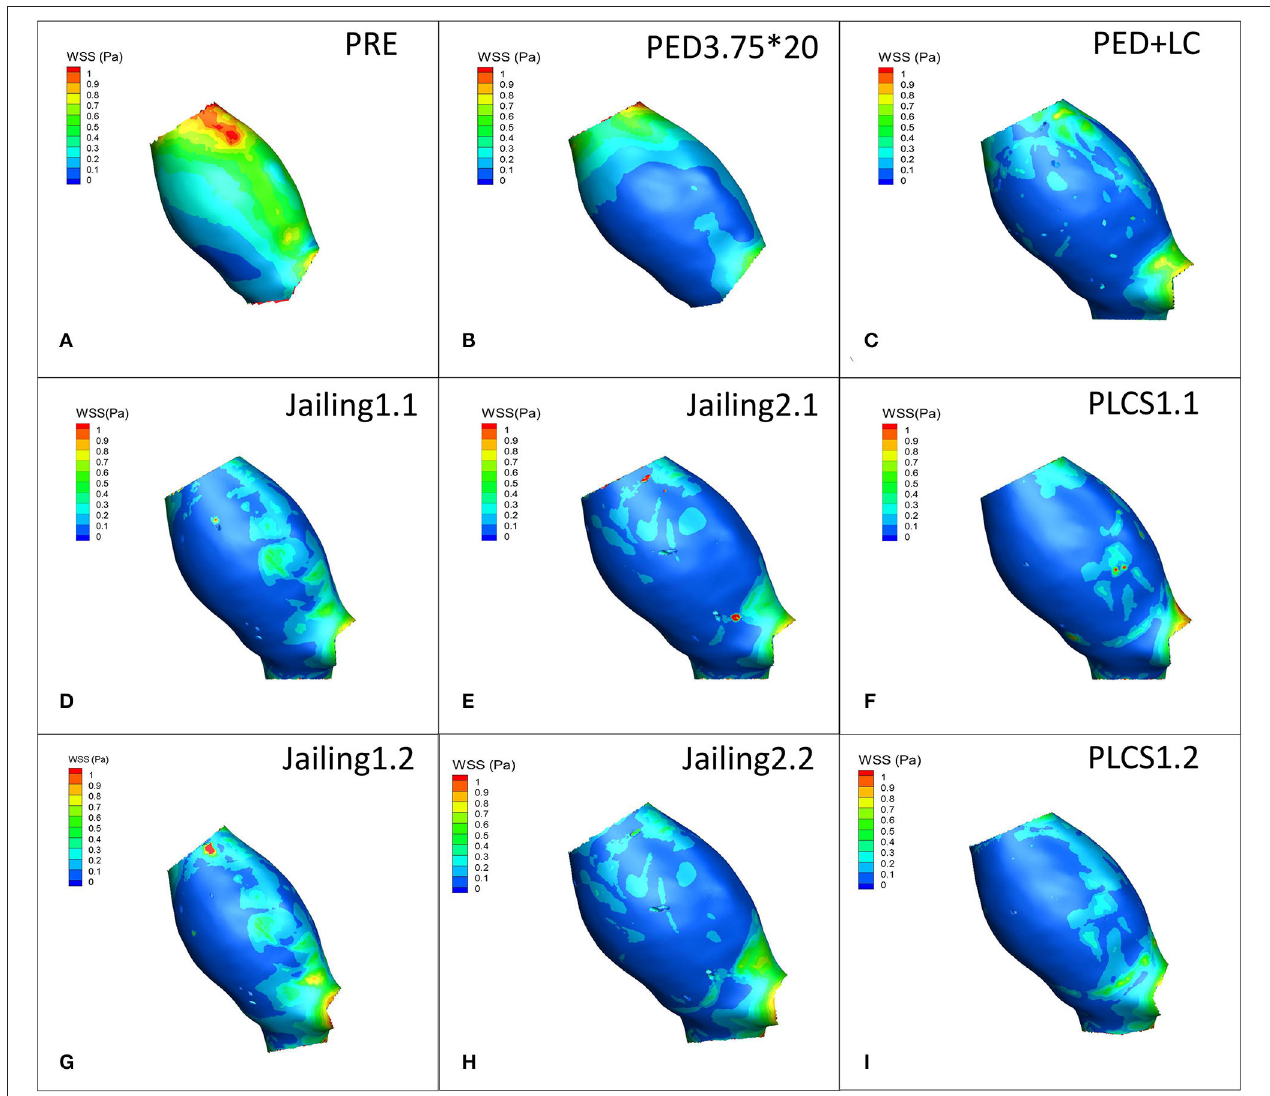
FIGURE 8 | (A) Preoperative WSS. (B–I) WSS of PED, PED + LC, Jailing, and PLCS post-operative models.